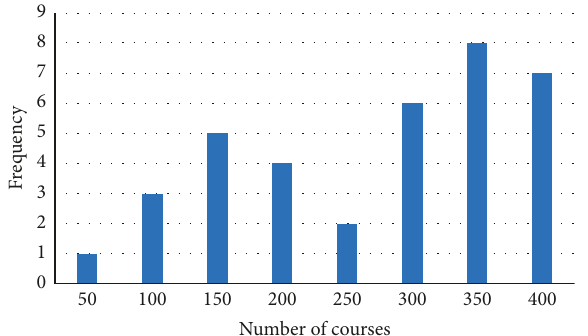
Figure 6: Hotness distribution chart of learner A.